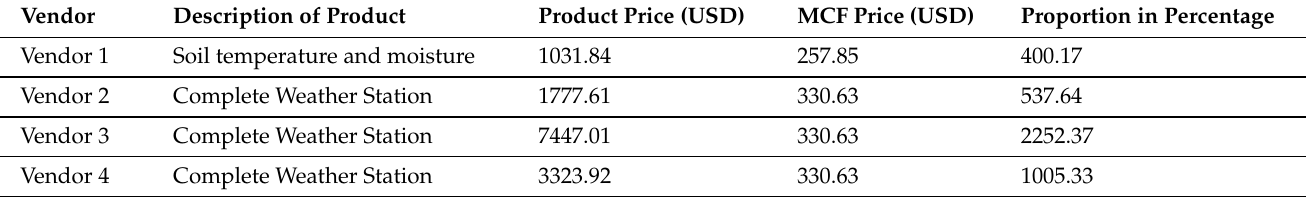
Table 1. A price comparison between the MCF’s MS use-case and similar commercial